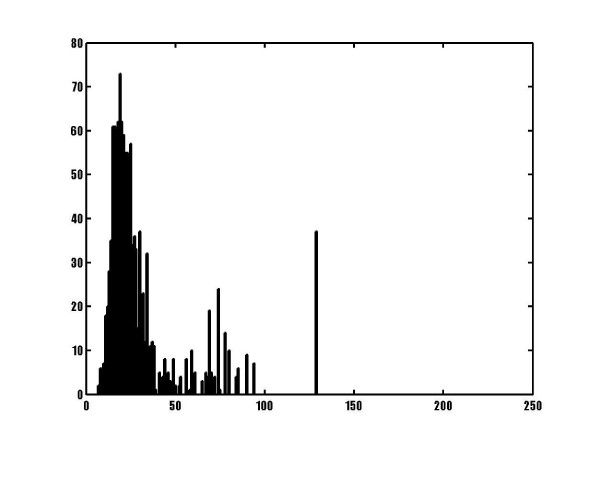
Histogram of similar words for the knirps cis-regulatory module. An example of a distribution of similar 5-mer words for the knirps cis-regulatory module Drosophila melanogaster . Note that the sequence contains an exceptionally large number (37) of lists with an exceptionally large number (137) of similar words. The Y axis shows the number of lists, the X axis is for list size.